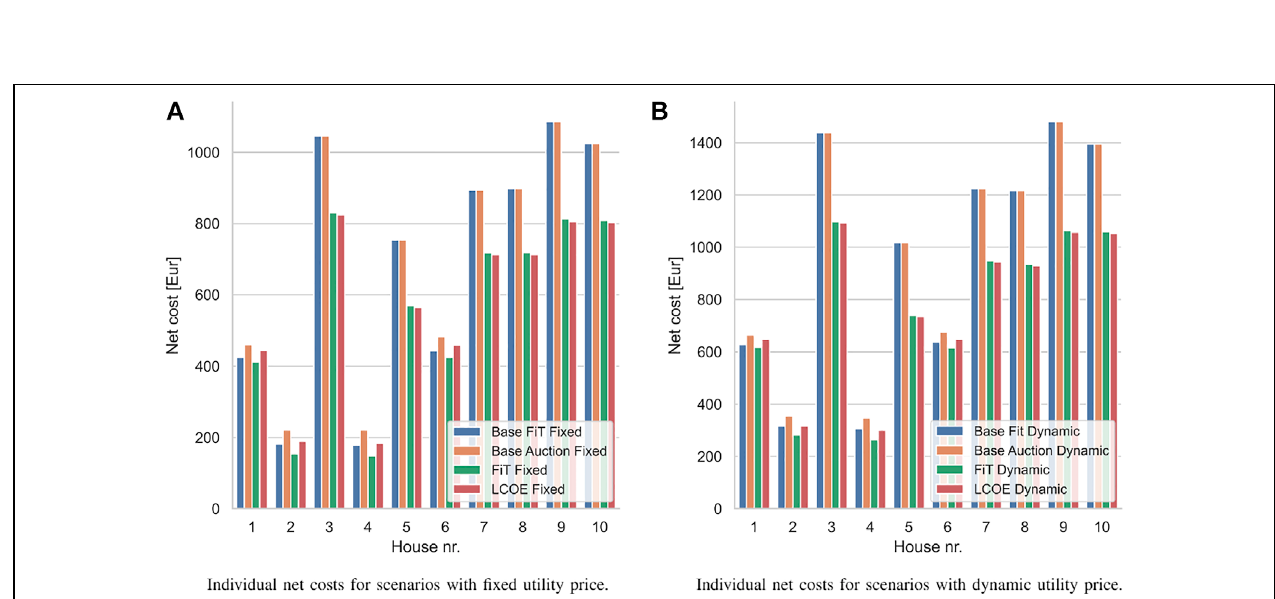
FIGURE 9 | Comparison of the daily average LEM prices for each month for the (A) FiT scenario and (B) LCOE scenario with dynamic utility price.